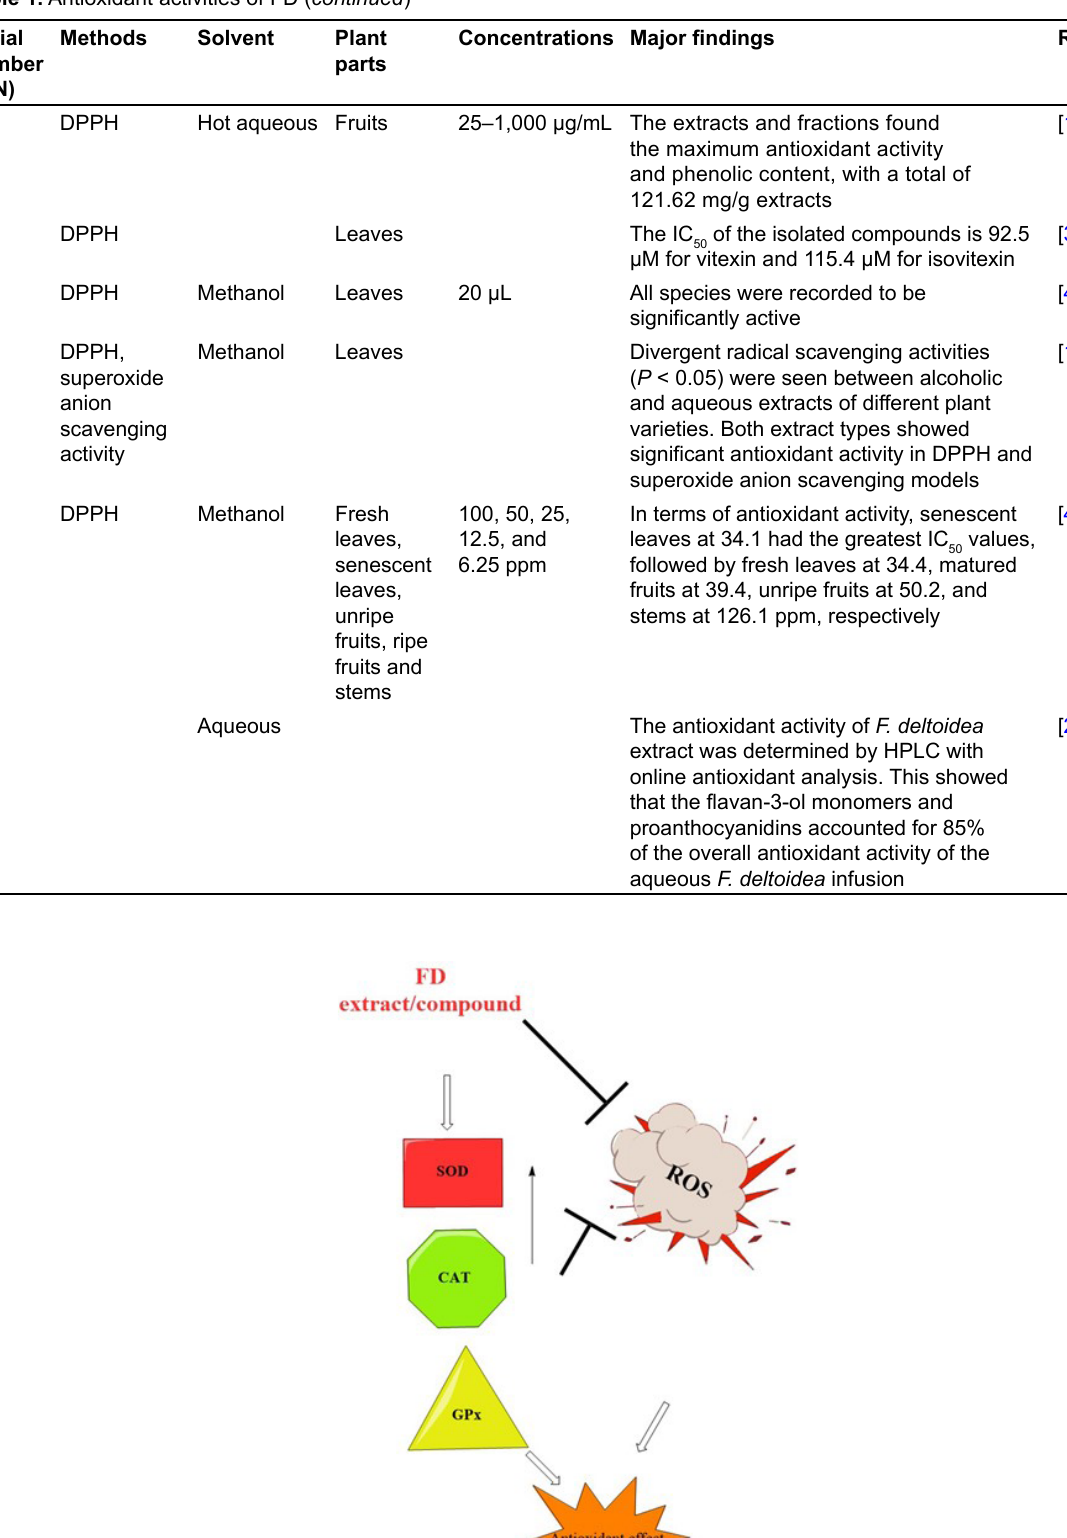
Table 1. Antioxidant activities of FD ( continued )